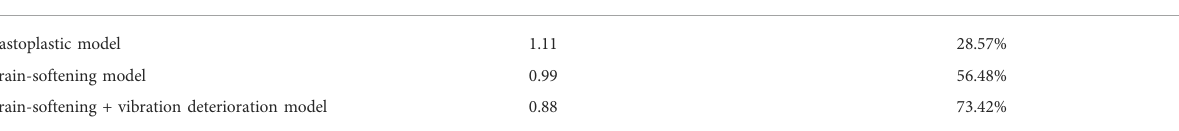
TABLE 3 Stability evaluation index under different